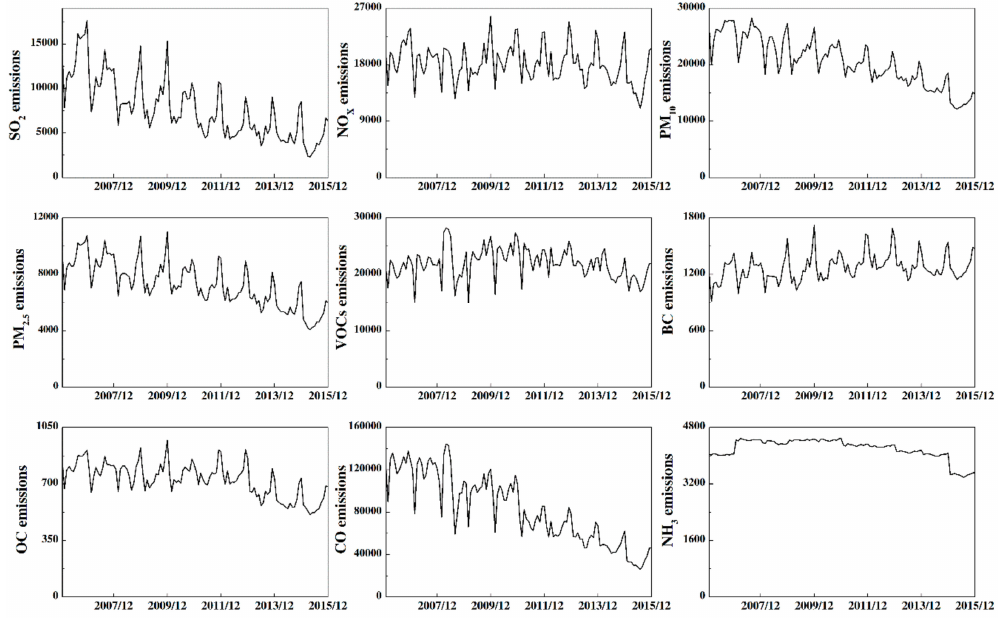
Figure 4. Monthly emissions variations of air pollutant in Beijing between 2006 and